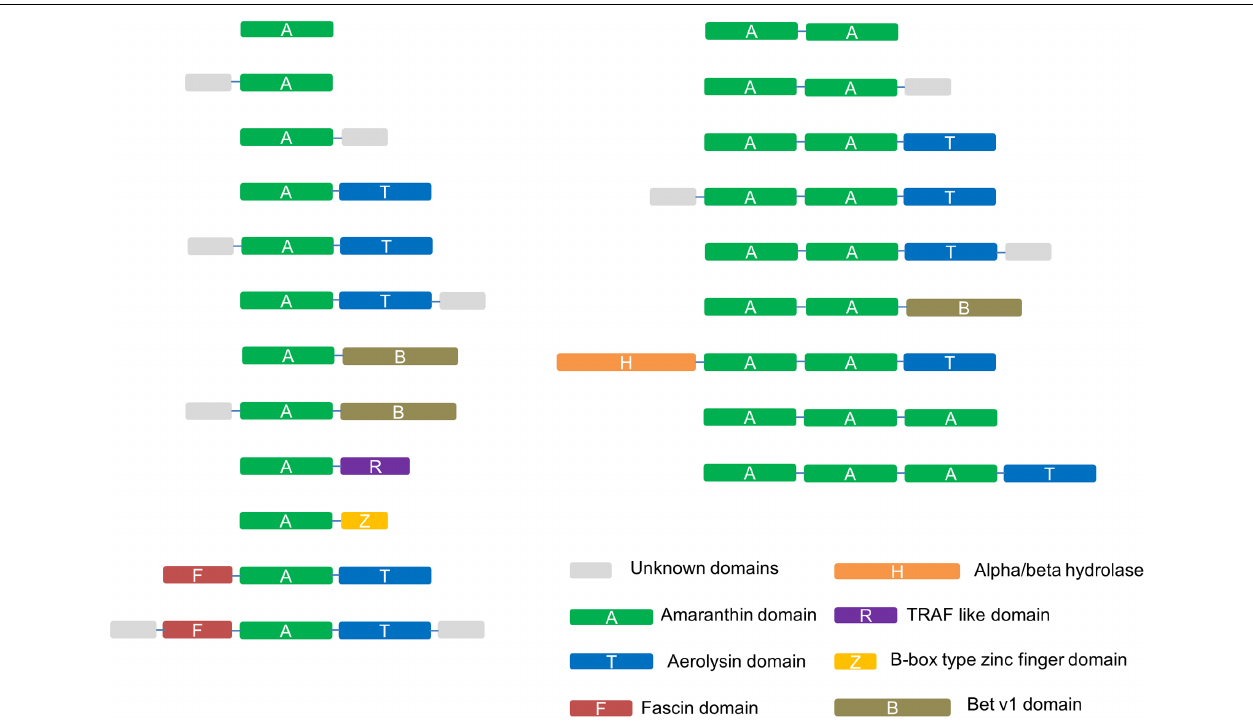
FIGURE 2 | Schematic representation of the identified amaranthin domain architectures in 34 plant genomes. Unknown domains are sequences longer than 50 amino acids at the N-terminus or C-terminus that show no sequence homology to any protein domain with known